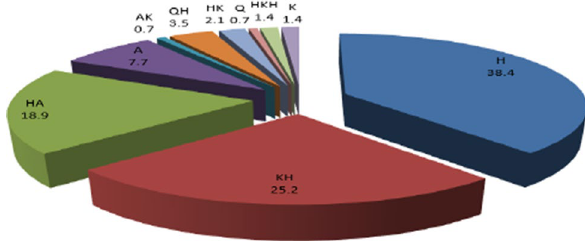
Fig. 8 Pie chart showing the distribution of curve types obtained from VES in the study